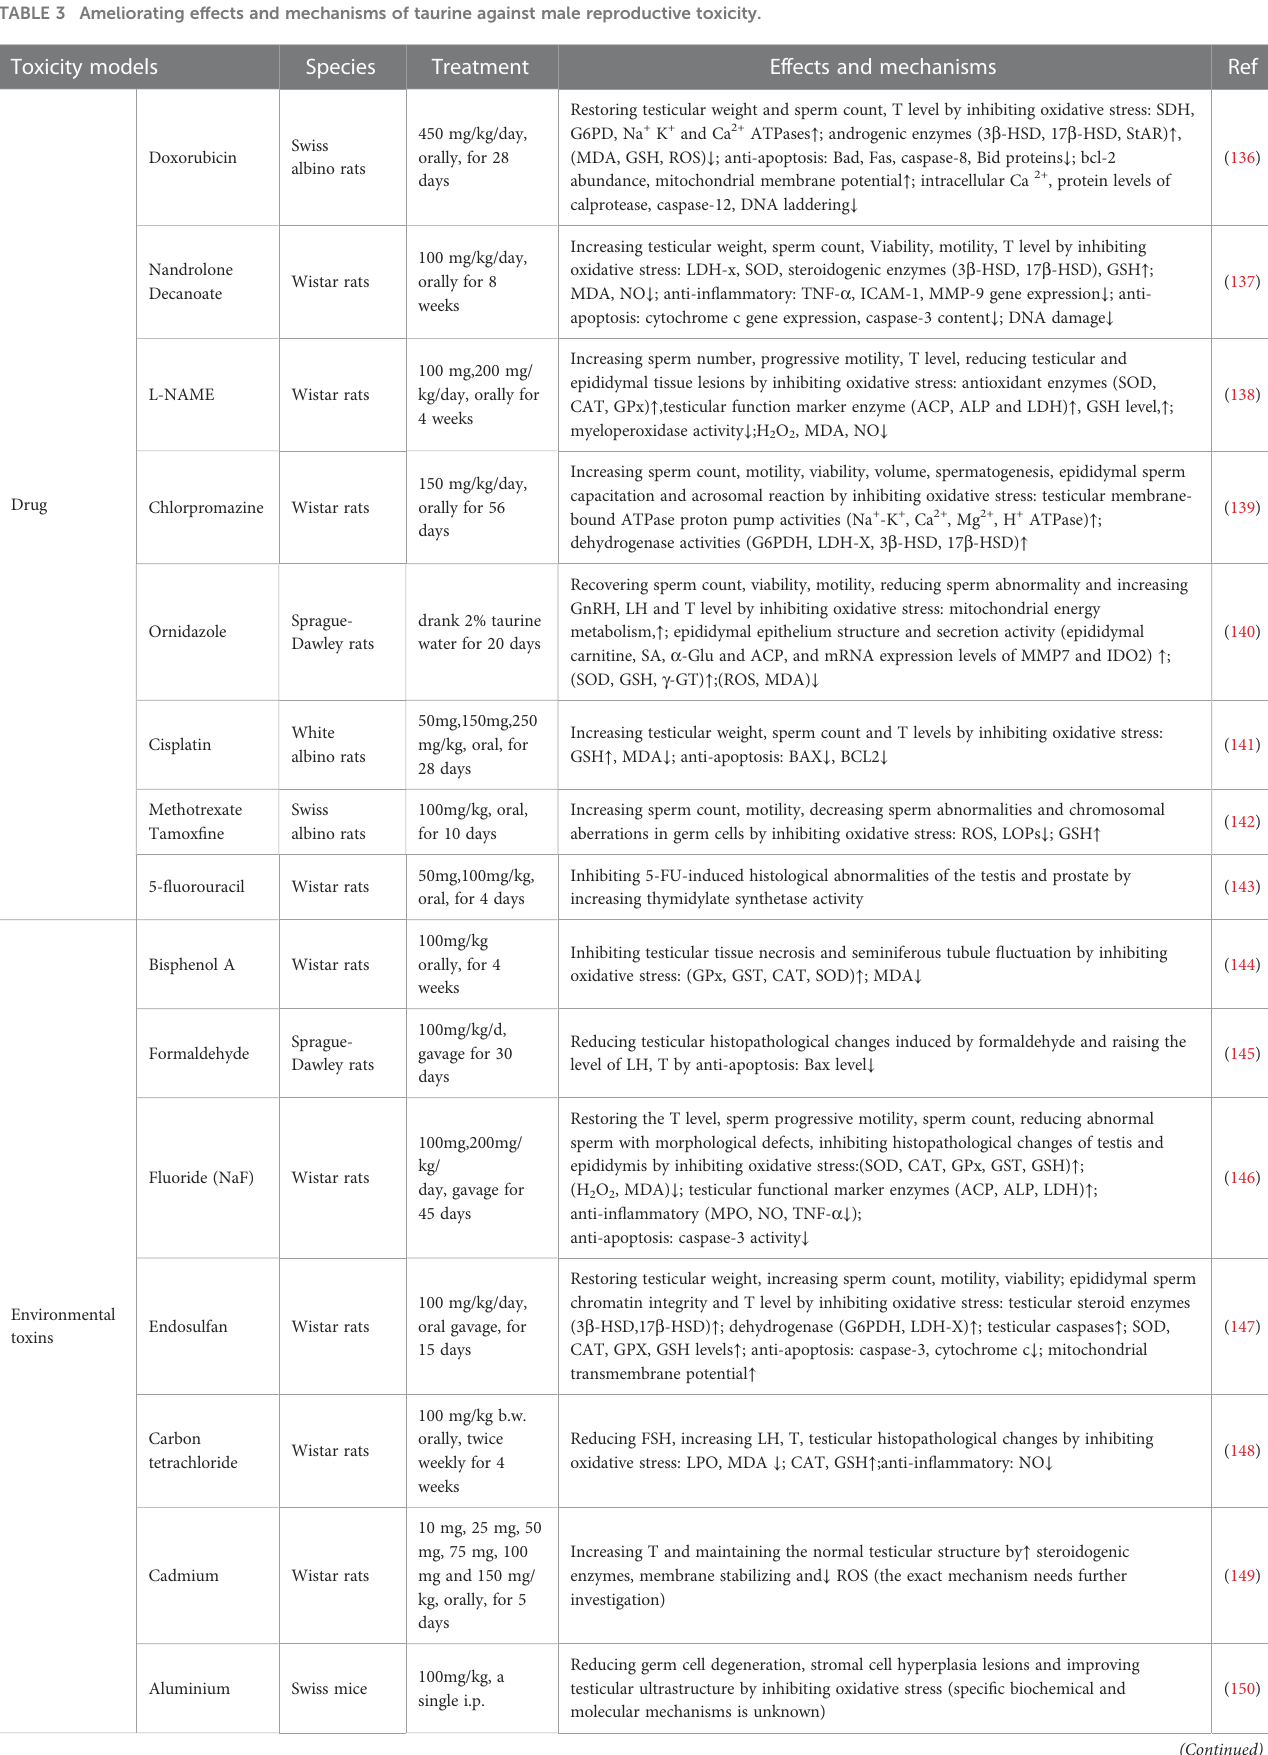
TABLE 3 Ameliorating effects and mechanisms of taurine against male reproductive toxicity. Toxicity